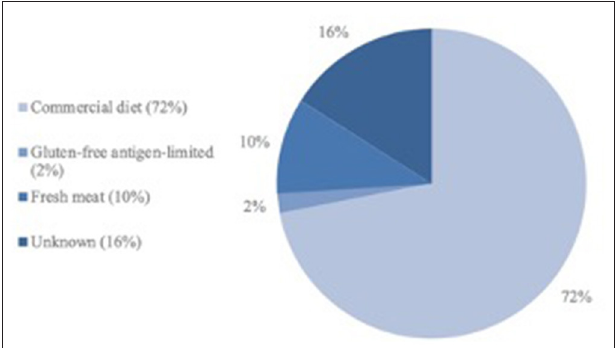
FIGURE 1 | Types of food of the study